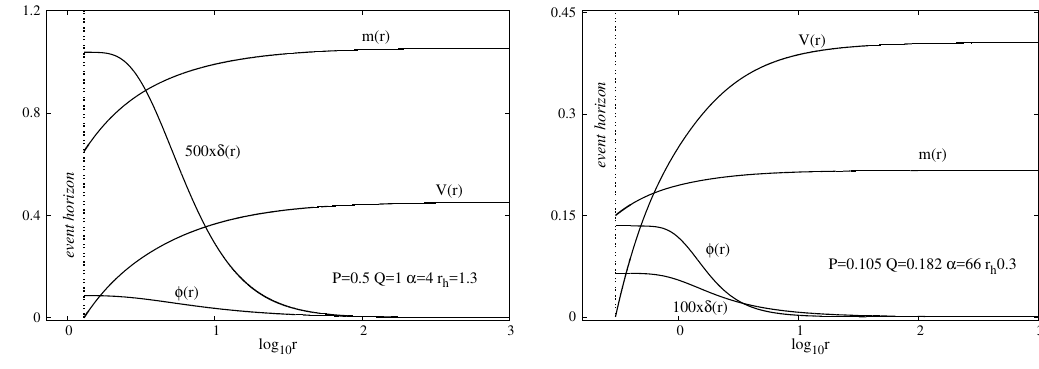
Figure 3 . Examples of dyonic BHs radial pro(cid:12)le functions for a dilatonic (left panel) and a scalarised (right panel)